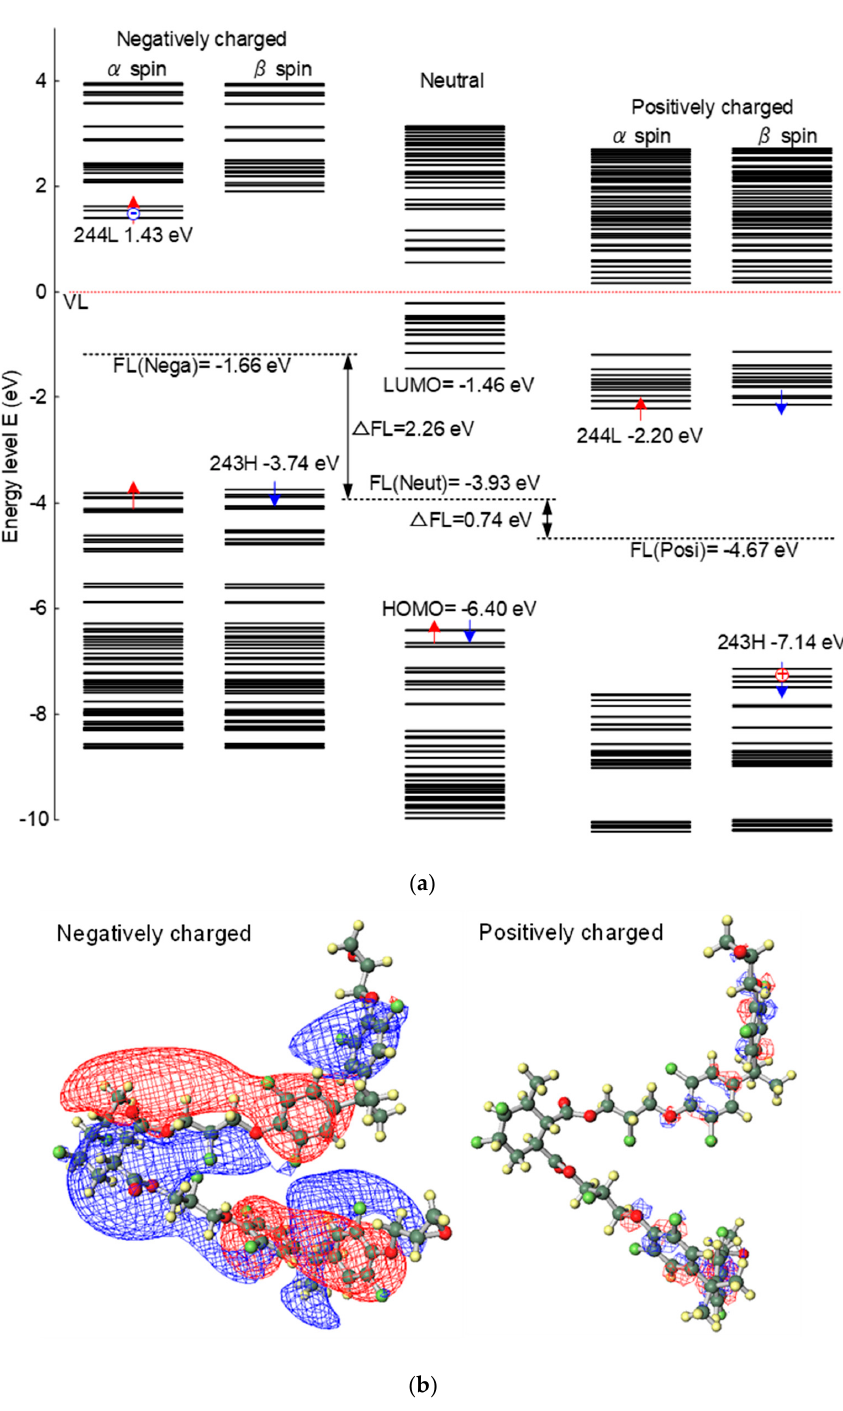
Figure 4. Energy level distribution and molecular orbitals of epoxy resin under different charging conditions. ( a ) Energy level distribution of different charged epoxy; ( b ) molecular orbitals of LUMO under negatively charging and HOMO under positively charging.